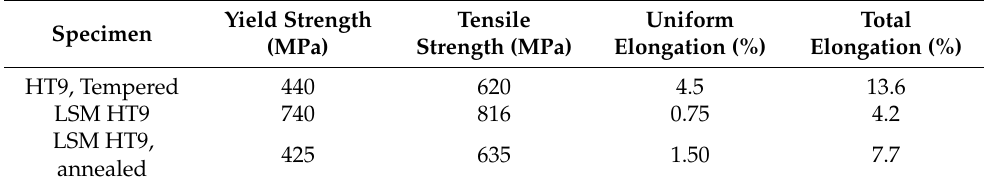
Table 3. Summary of the average tensile properties of the different specimens tested in the present